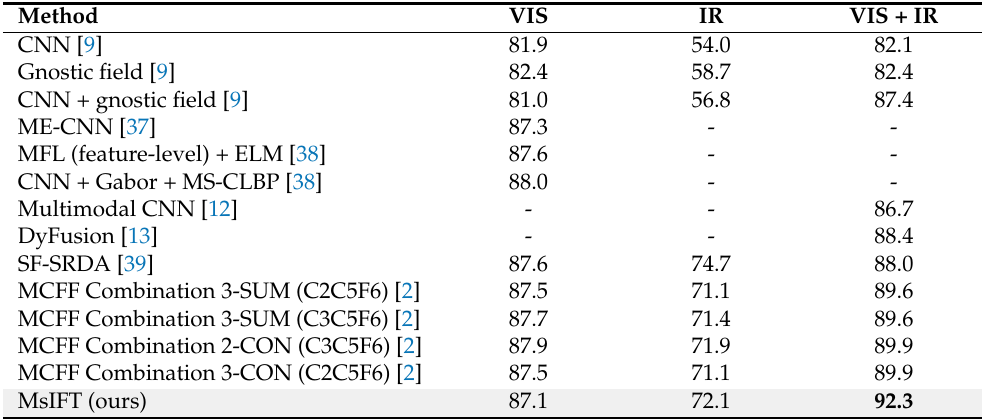
Table 4. Performance comparison on VAIS dataset.